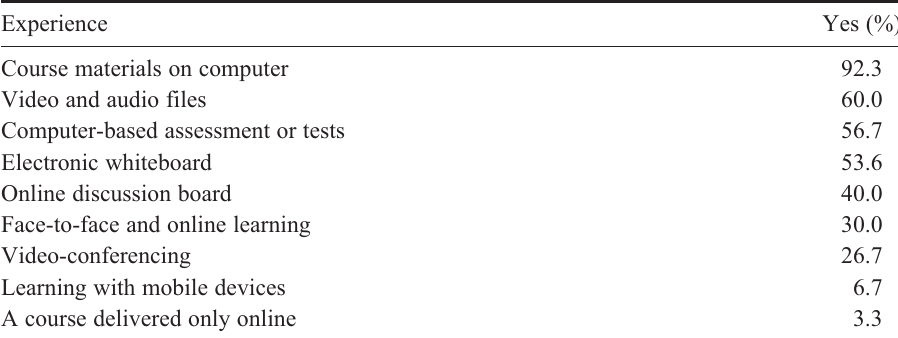
Table 3. Previous experiences of e-learning scenarios.